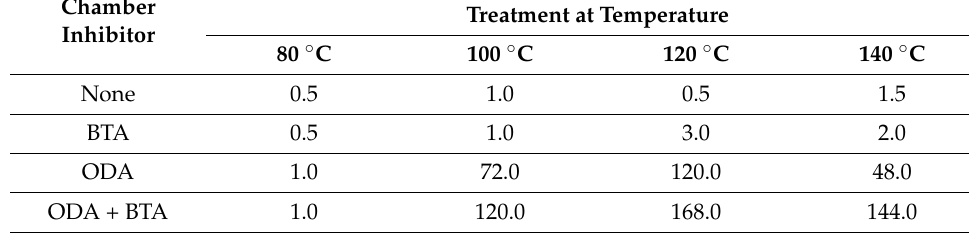
Table 1. PAE of the adsorption films formed upon steel treatment in CIN vapors at various tempera- tures. Recurrent moisture condensation conditions. τ CE = 1